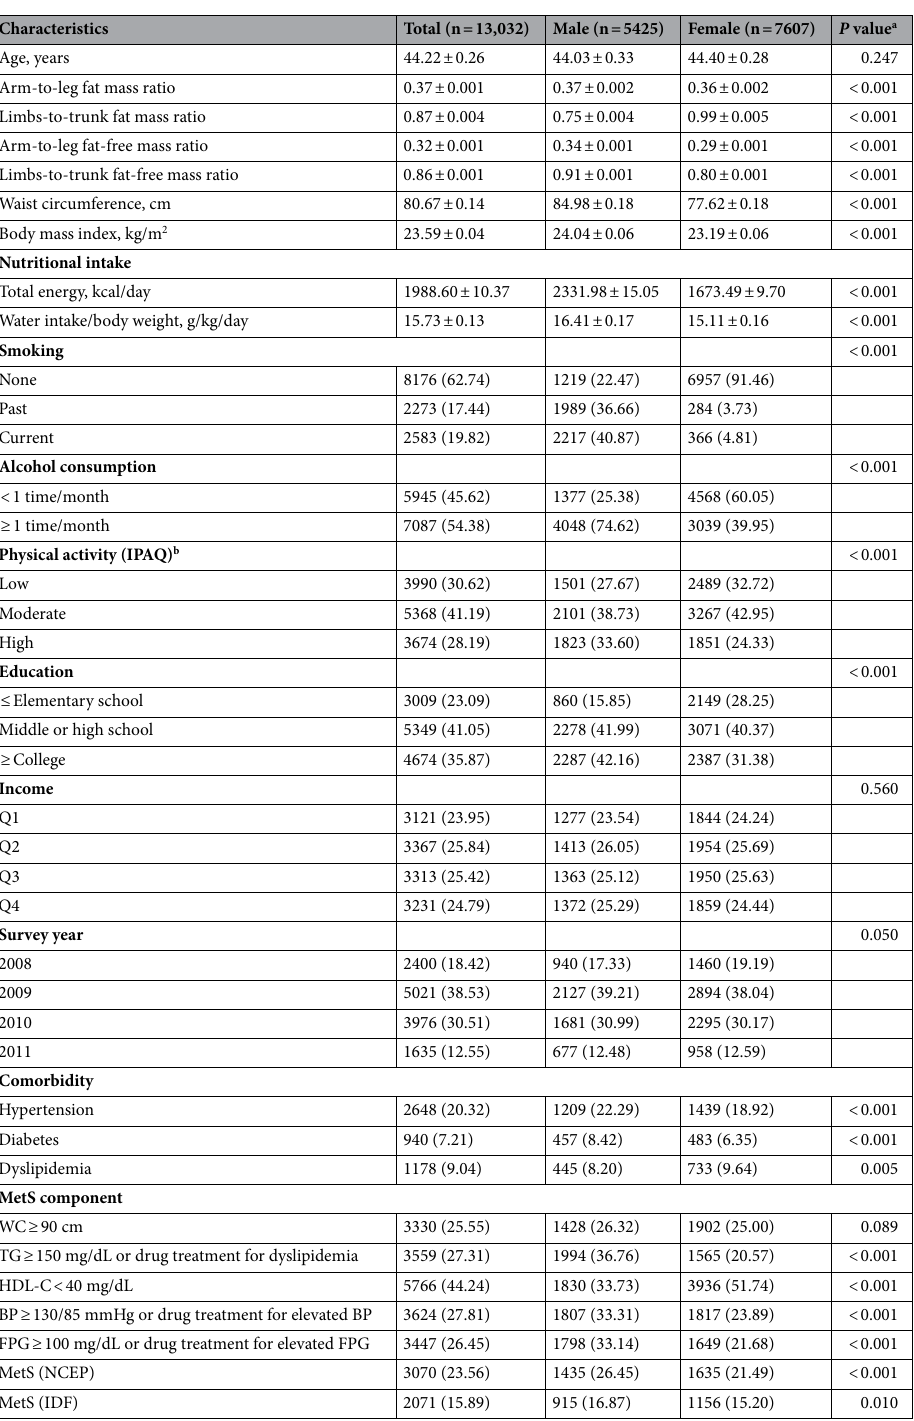
Table 1. General characteristics of the study participants. Data are presented as mean ± SE for continuous variables and numbers (%) for categorical variables. IPAQ, International Physical Activity Questionnaire; MetS, metabolic syndrome; WC, waist circumference; TG, triglyceride; HDL-C, high-density lipoprotein cholesterol; BP, blood pressure; FPG, fasting plasma glucose; NCEP, 2005 National Cholesterol Education Program Adult Treatment Panel III; IDF, 2006 International Diabetes Federation. a P value from linear regression analysis for continuous variables or χ 2 test for categorical variables, comparing differences between two groups. b Categorical variable from the International Physical Activity Questionnaire research